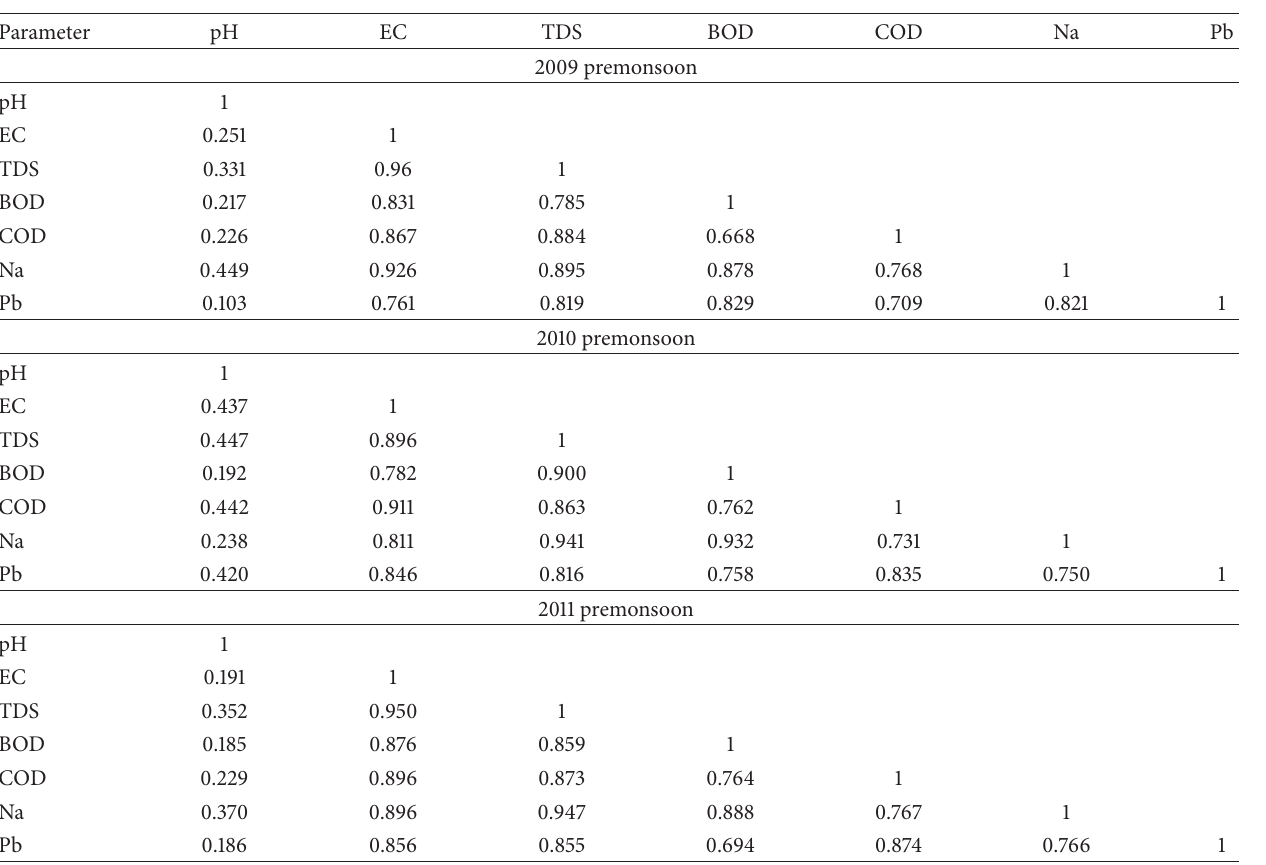
Table 7: Correlation coefficient ( 𝑟 ) for different water quality